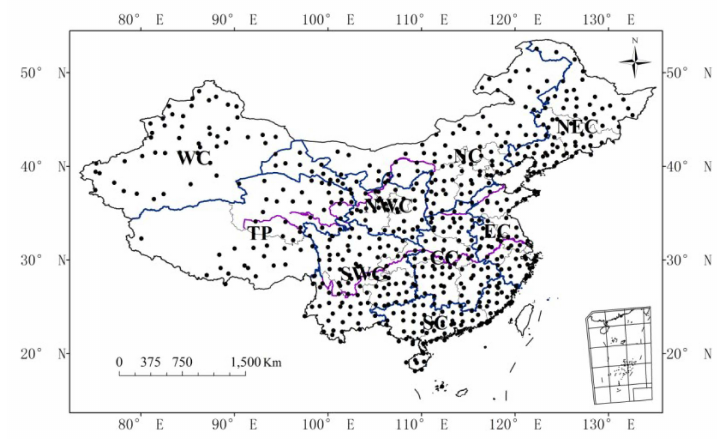
Figure 1. Distribution of the weather stations and climate zones. The upper curved purple line is the Yellow River and lower curved purple line is the Yangtze River. The blue line is used to separate the different climate zones. See text for climate zone